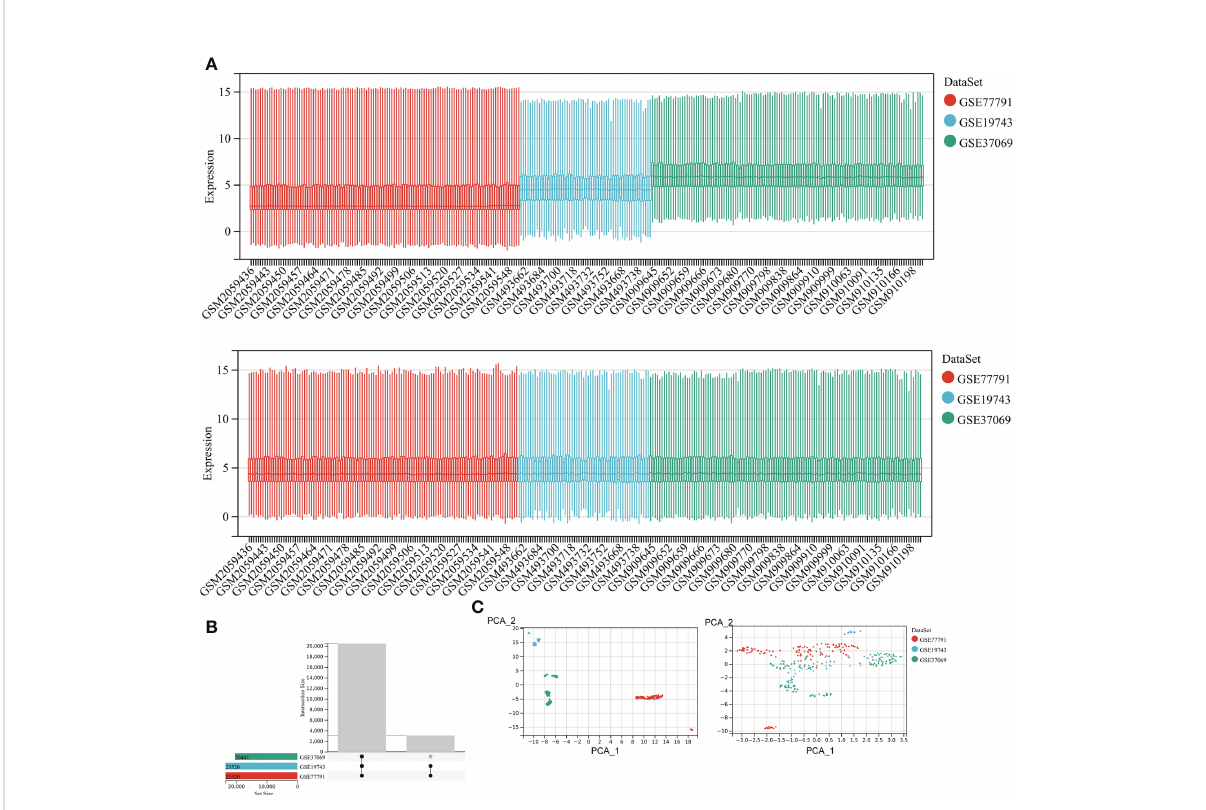
FIGURE 2 Correcting for batch effects. (A) Bar graphs with different colors represent different data sets. The ordinate is the expression value of the microarray data, and the abscissa is the sample number. (B) Overlapping genes after converting gene names between different datasets. (C) Sample expression pro fi les before batch correction and after batch